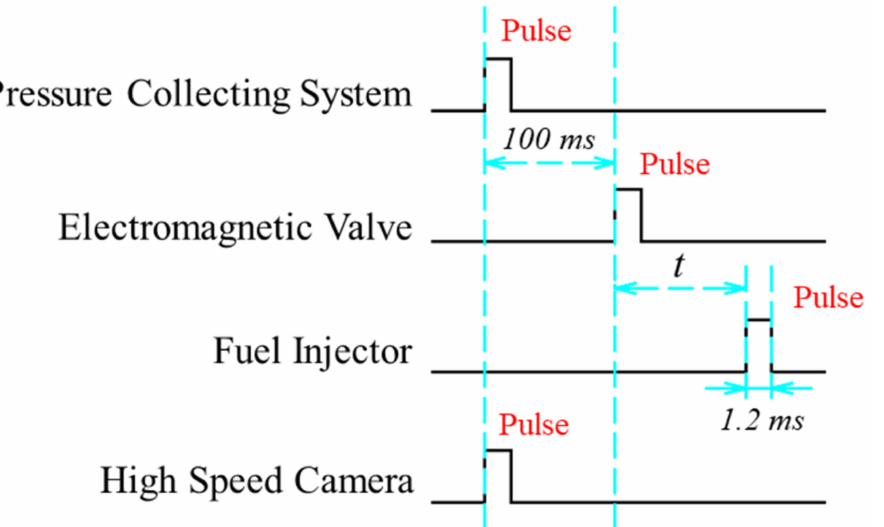
Figure 2. Time sequence of different trigger